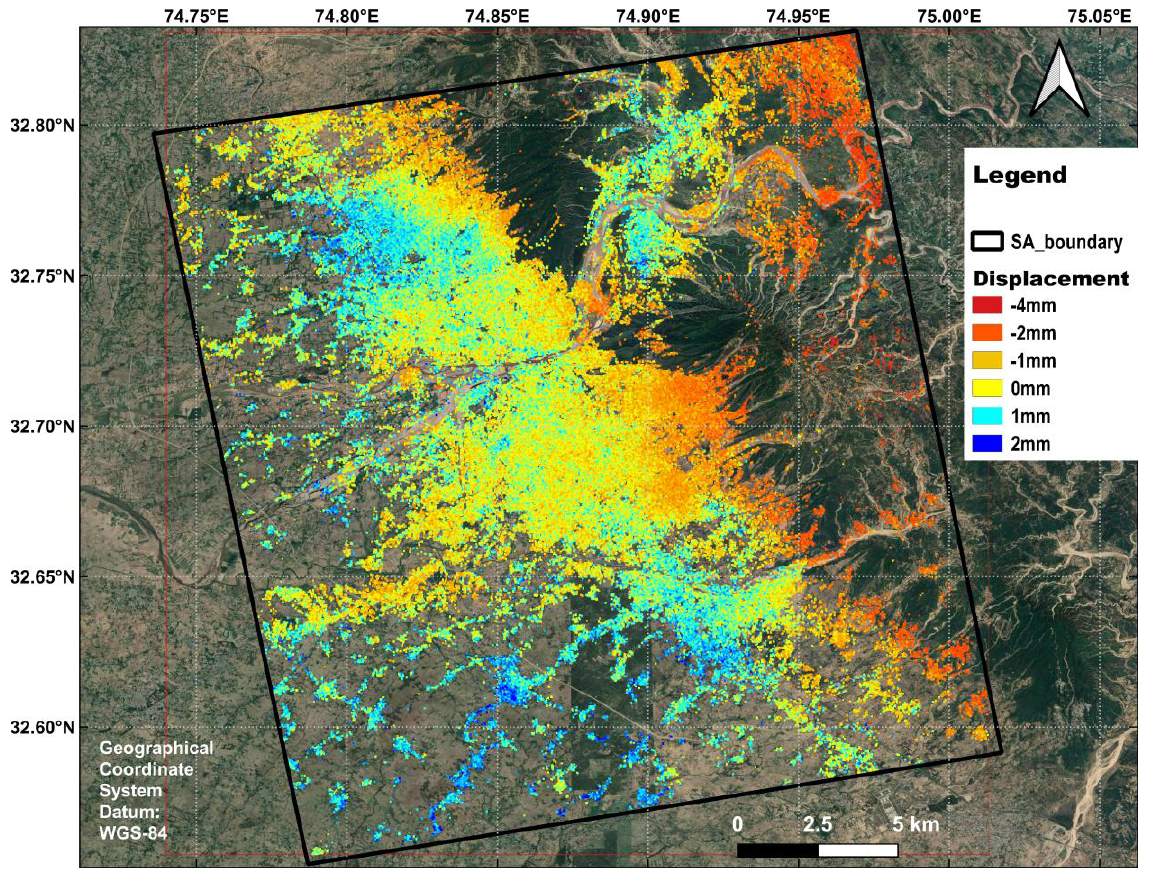
Figure 7. The line-of-sight displacement observed from PSInSAR processing of Sentinel-1 datasets depicting dominant subsidence in the mountain areas with some upliftment in the sub-urban plain area of the Jammu region.